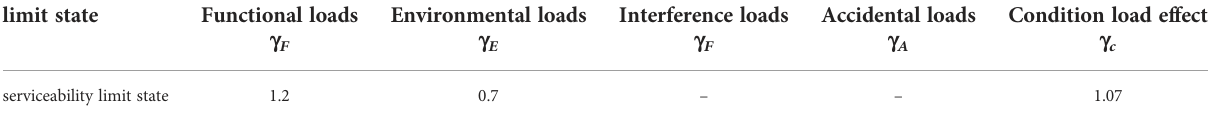
TABLE 3 Load effect factors according to the serviceability limit state.